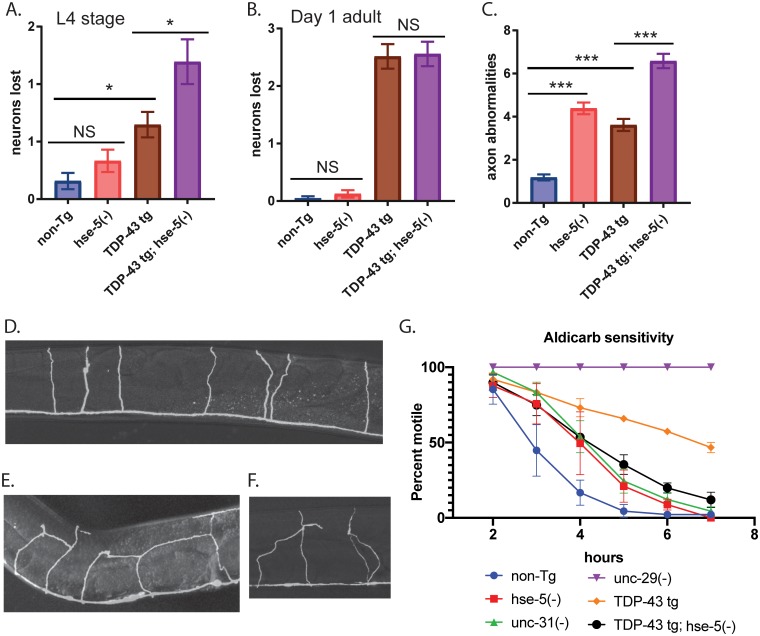
hse-5 loss of function restores synaptic transmission in TDP-43 tg C. elegans.(A) To assess neurodegeneration, GFP-labeled D-type GABAergic motor neurons were counted at L4 stage in vivo in living worms. TDP-43 tg; hse-5(tm472) animals lose slightly more neurons than TDP-43 tg alone, N>33 for all strains tested. Significance was evaluated using one-way analysis of variance with Tukey’s multiple comparison test among strains tested. *p<0.05, non-Tg versus TDP-43 tg and TDP-43 tg versus TDP-43 tg; hse-5(tm472), NS = not significant. (B) At day 1 adult, there are no differences in the number of D-type GABAergic motor neurons between TDP-43 tg versus TDP-43 tg; hse-5(tm472), N>33 for all strains tested. NS = not significant. p<0.0001 for non-Tg versus TDP-43tg and TDP-43 tg; hse-5(tm472). (C) hse-5(tm472) exhibit numerous axonal abnormalities including aberrant branching, looping, and inter-axonal connections. These non-canonical processes are increased in TDP-43 tg; hse-5(tm472) animals, N>33 for all strains tested. ***p<0.0001 for non-Tg versus hse-5(tm472), TDP-43tg, and TDP-43 tg; hse-5(tm472), and for TDP-43tg versus TDP-43 tg; hse-5(tm472). (D) Wild-type control axons ascend linearly from the ventral nerve cord without branching, looping, or inter-axonal connections. (E-F) TDP-43 tg; hse-5(tm472) axons frequently exhibit unusual branches, loops, or inter-axonal connections. (G) Pre-synaptic transmission was assessed using an aldicarb sensitivity assay. Animals were scored at the indicated time points for paralysis. Triplicate independent experiments are plotted. TDP-43 tg animals (orange diamond, p<0.005 at hours 3–7) are strongly resistant to aldicarb relative to non-Tg animals (blue circle) indicating decreased or defective synaptic transmission, while hse-5(tm472) animals (red square, p<0.05 at hours 3–4) are more modestly resistant to aldicarb. TDP-43 tg; hse-5(tm472) animals (black circle, p<0.05 at hours 3–5) have synaptic transmission restored to hse-5(tm472) levels. unc-29(e1072) (purple inverted triangle, p<0.05 at hours 3–7) and unc-31(e928) (green triangle, p<0.05 at hours 3 and 4) are controls for decreased aldicarb sensitivity. Significance was evaluated using two-way ANOVA with Tukey’s multiple comparisons test; p-values compared to non-Tg.